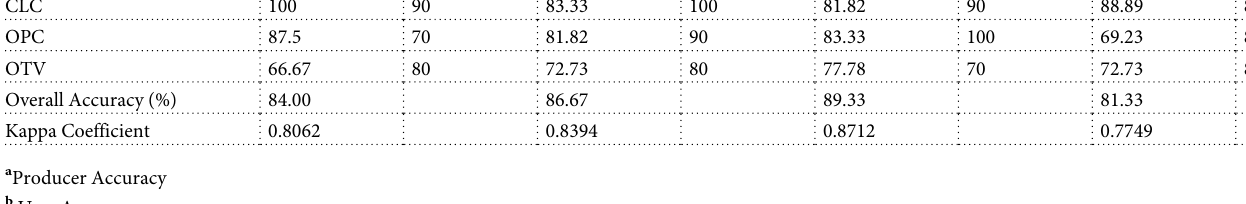
the category level. If a class’s bar goes beyond the UI line, then the gain or loss intensity for that class is active, but if a bar stops before the UI line, then the intensity is dormant. Six active categorical changes in terms of loss and gain during 1990–2000: URB gain, WAT gain, WAT loss, CLC loss, OPC gain, OPC loss, OTV gain and OTV loss are shown in Fig 4. All other gains and losses show dormancy. For 2000–2010, six active categorical changes are revealed (Fig 4C): URB gain, URB loss, CLC loss, OPC gain, OTV gain and OTV loss. All other gains and losses exhibit dormancy. Similarly, seven active categorical changes were discovered dur- ing the 2010–2014 interval: URB gain, URB loss, CLC gain, CLC, loss, OPC loss, OTV gain and OTV loss. The extra gains and losses revealed dormancy during this interval (Fig 4E). The observed change area for each active class is the sum of uniform change and commission error at each interval, while the observed change area for each dormant class is the sum of the observed change and omission error at each interval (Fig 4B, 4D and 4F). AGR, OPC and CLC have the largest gains and losses, while URB and OTV have the highest intensities with small sizes of losses and gains, which account for their high intensities. AGR loss and gain intensities